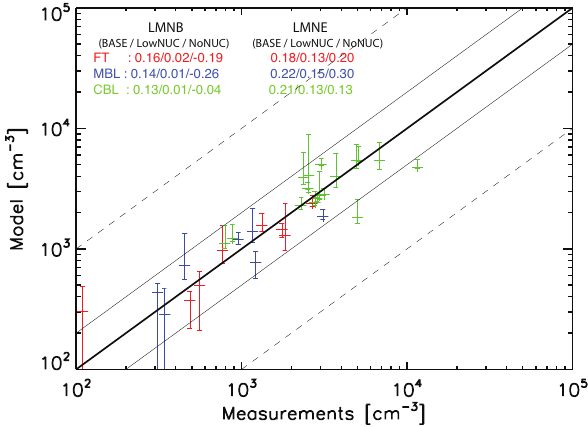
Figure 21. Scatter plot of simulated annual-mean aerosol number concentrations in comparison with a data set of surface number con- centrations measurements at 36 sites around the world compiled by Spracklen et al. (2010). The top horizontal bar represents the BASE results, and the middle bar the LowNUC results and the lower bar the NoNUC results. Red color is for free troposphere (FT); blue for marine boundary layer (MBL); green for continental boundary layer